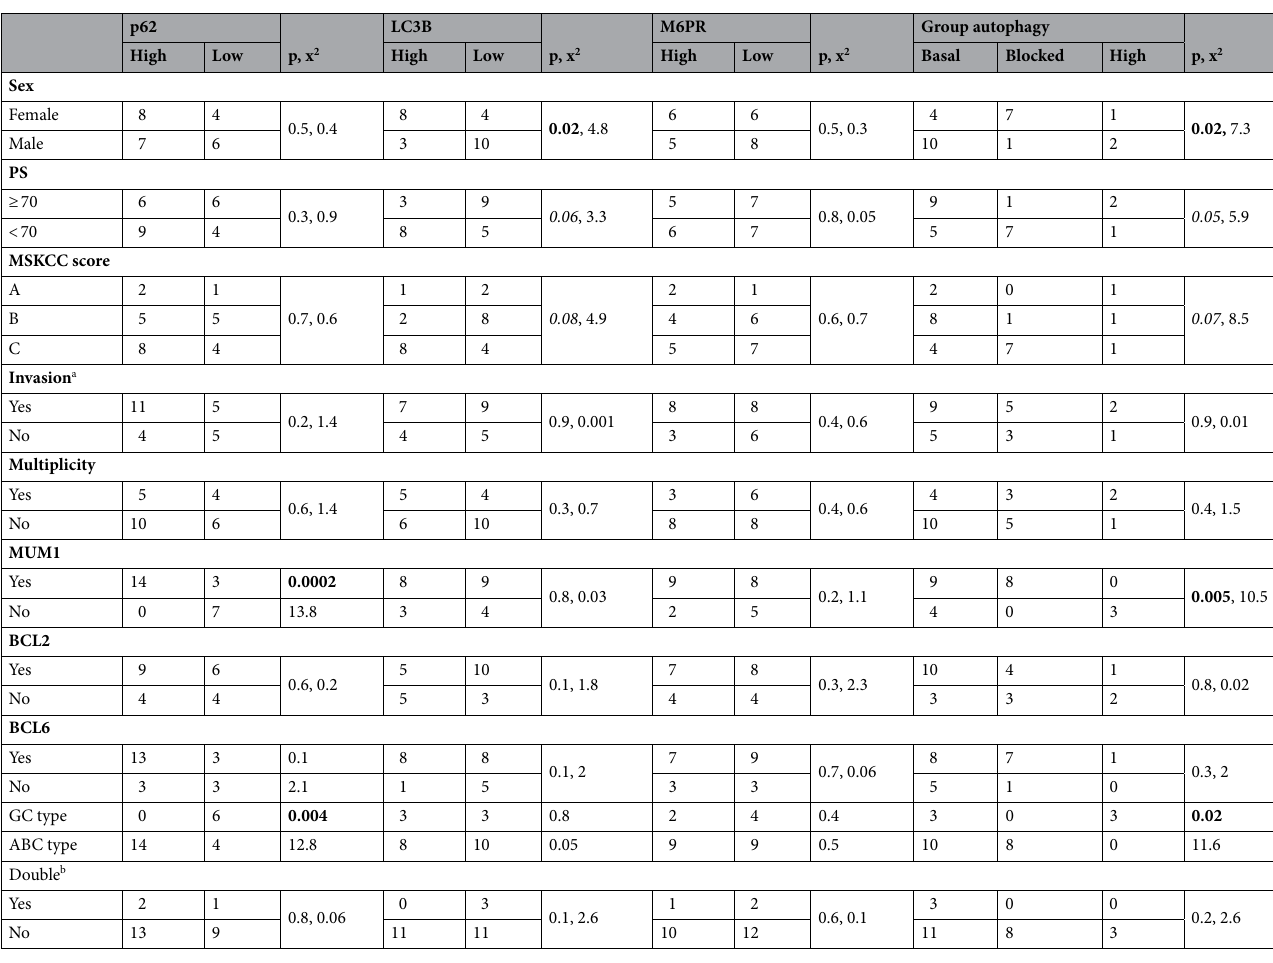
Table 3. Correlations of immunohistochemical findings. Bold denotes statistical significance; italics denote statistical trend. MSKCC: Memorial Sloan Kettering Cancer Center. a Invasion of deep brain structures. b Double MYC/BCL2 co-expressors.